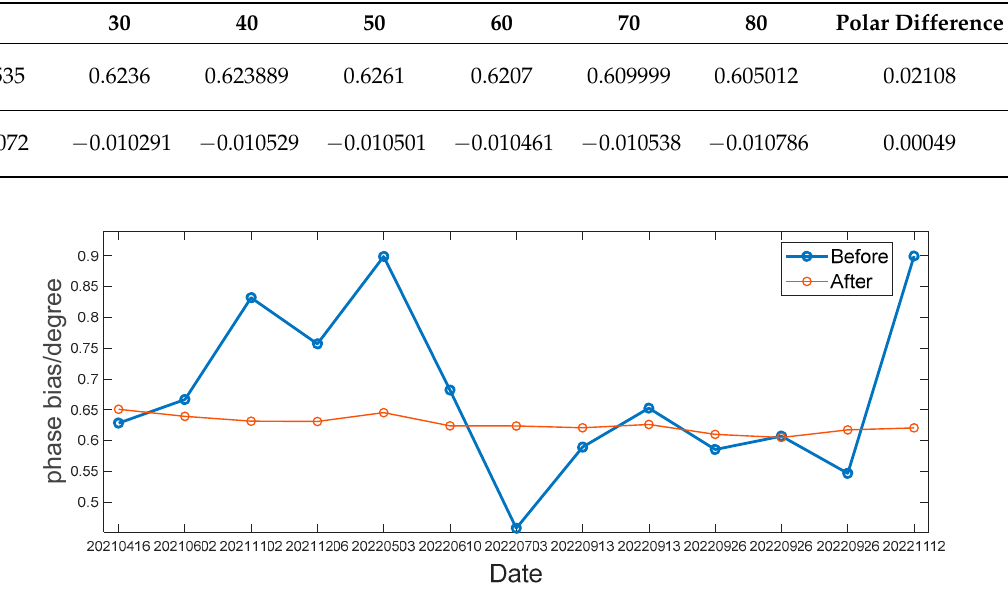
Table 4. Carrier characteristic bias for BDS3 prn 21.